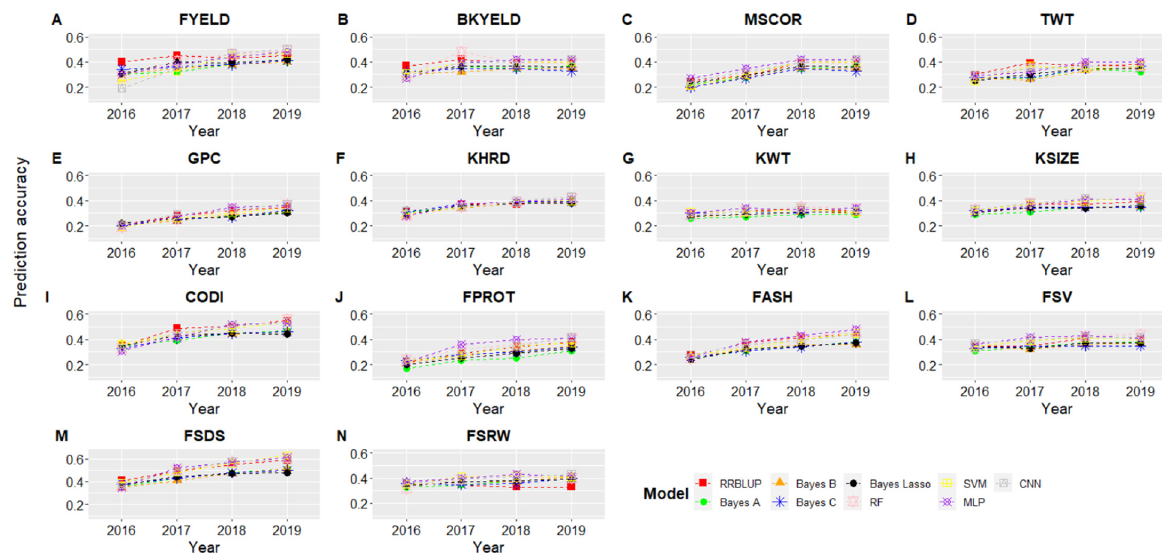
Figure 3. Genomic selection forward prediction accuracies for Pullman, WA, when all datasets from previous years were included to predict fourteen end-use quality traits using nine different models. The x -axis represents the year for which predictions were made using previous years as training set. All abbreviations are previously abbreviated in the text and